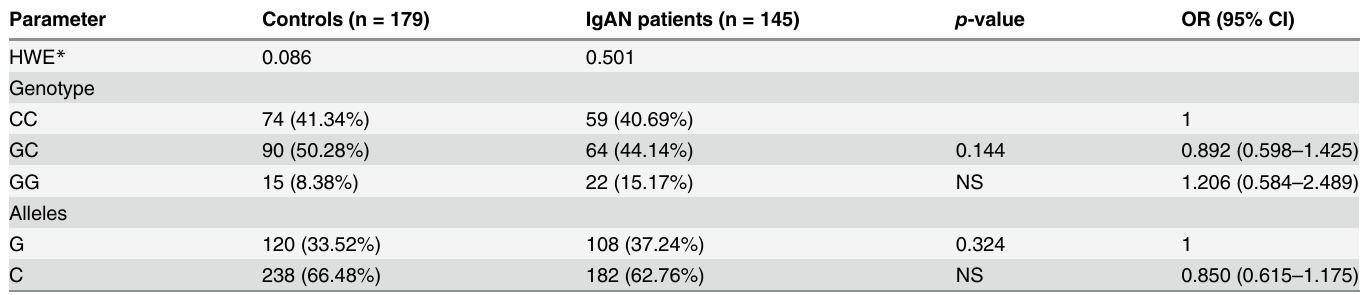
Table 2. Genotype and allele distributions of rs2910164 C >